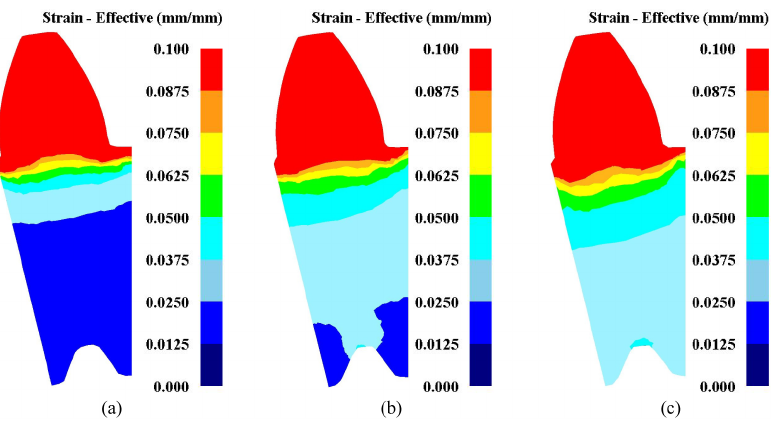
Figure 7. Effective strain of reshaped teeth at various finishing tools: ( a ) Mandrel with gap; ( b ) mandrel without gap; and ( c ) interference mandrel.